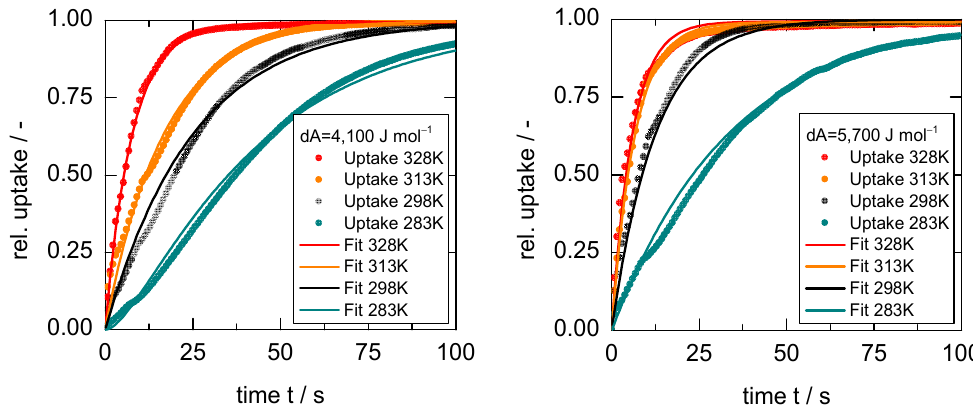
Figure 9. Gas uptake curves for n -butane on 1 at 283, 298, 313, and 328 K for changes in adsorption potential of dA = 4100 J mol − 1 ( left ) and dA=5700 J mol − 1 ( right ) with respect to A GOE .